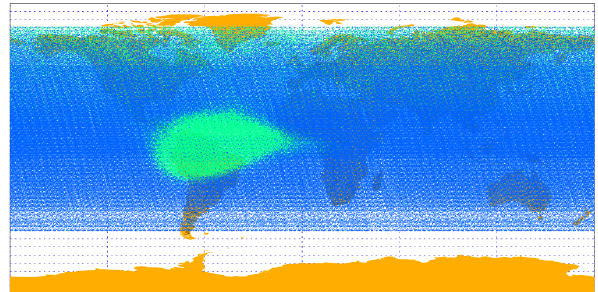
Figure 2. Geographical locations of nighttime limb-emission obser- vations performed by SCIAMACHY between 2 August 2002 and 8 April 2012. Limb measurements marked in green are excluded because they are affected by Aurora Borealis, highly energetic par- ticles in the South Atlantic Anomaly or by an enhanced offset pos- sibly related to contaminating emissions associated with the OH(7- 1) transition (Blackwell et al., 1960) and the NO + O air-afterglow continuum (e.g., von Savigny et al., 1999).